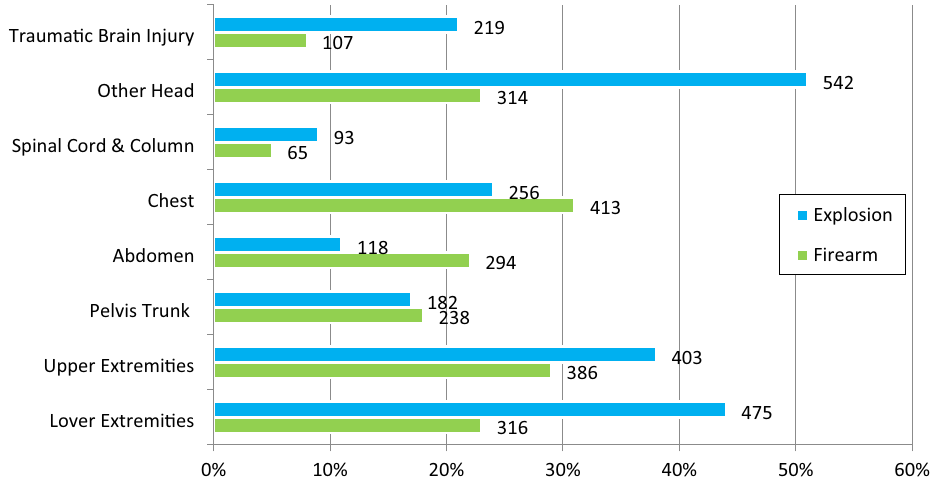
Figure 2. Injured body area by injury mechanism.